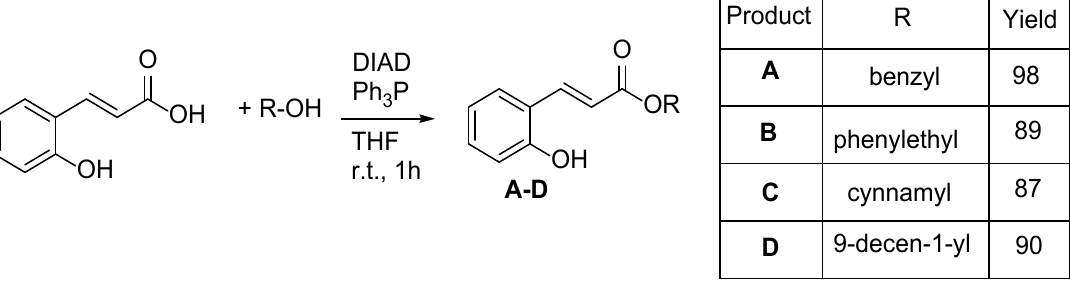
Scheme 1. Schematic representation of the preparation of the profragrances A – D .